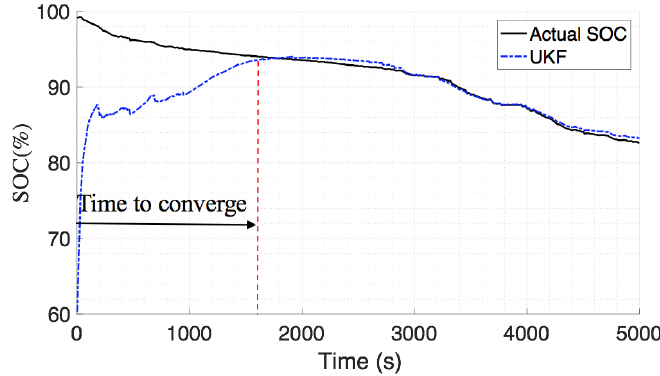
Figure 2. Slow convergence of UKF given 40% initial SOC estimation error.